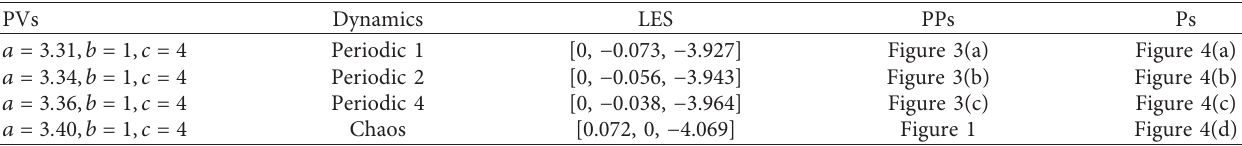
, x , and x plane. 1 2 3